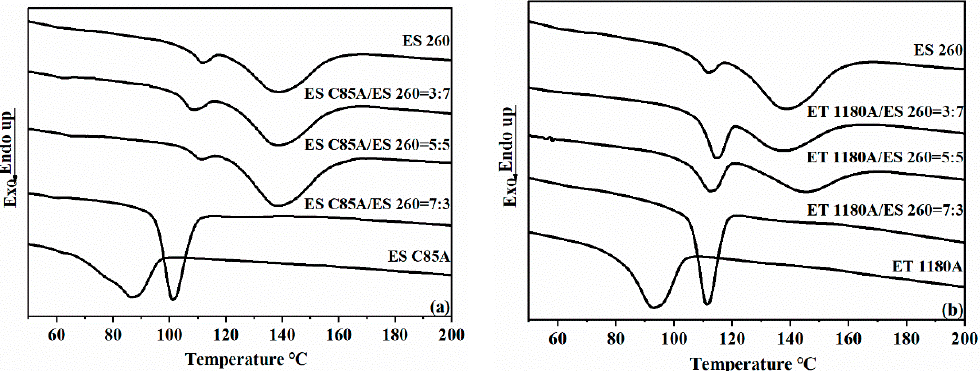
Figure 1. DSC curves showing the non-isothermal crystallisation of TPU and TPU blends during the cooling process: ( a ) ESC85A/ES260 blends, ( b ) ET1180A/ES260 blends. The single crystalline peak in the 30% ES260 blends is similar to that of pure TPU, indicating partial compatibility of the hard segments.